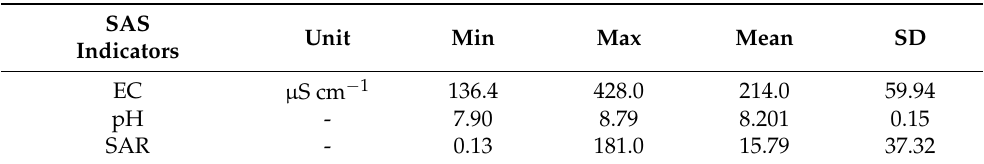
Table 2. Summary statistics of the indicators of salt-affected soils computed from the point observa- tions ( n = 85).